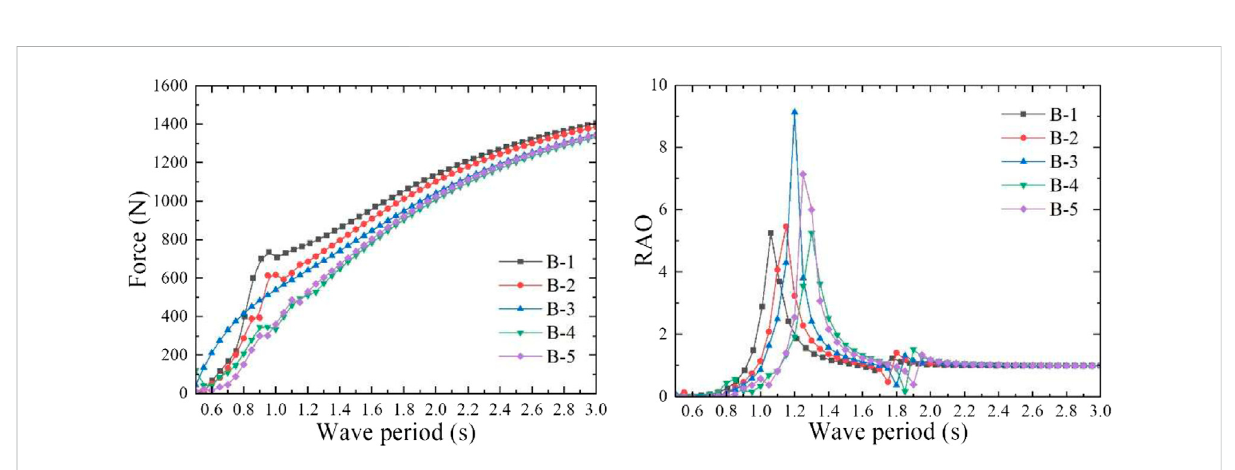
FIGURE 11 Wave excitation force on model B (left) and their heave RAO